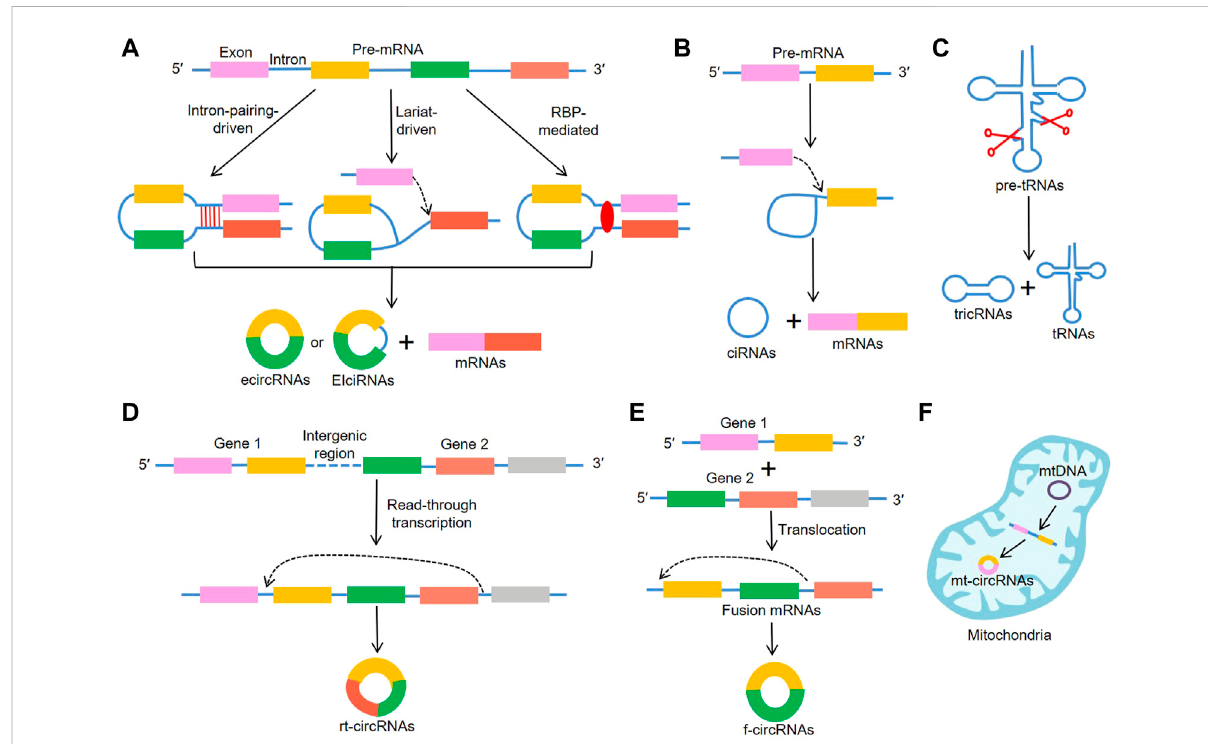
FIGURE 1 Biogenesis of circRNAs. (A) EcircRNAs or EIciRNAs can be generated by “ intron-pairing-driven circularization ” , “ lariat-driven circularization ” , “ RNA-binding proteins(RBP)-mediated circularization ” , (B) ciRNAs are generated fromintronic lariat precursors that escape thedebranching step of canonical linear splicing, (C) tricRNAs are generated during the splicing of pre-tRNA, (D) rt-circRNAs are from exons between neighboring genes on the same strand (intrachromosomal chimaeras), (E) f-circRNAs are fused exons between two distant genes (interchromosomal chimaeras), (F) mt-circRNAs are from mitochondrial genomes.